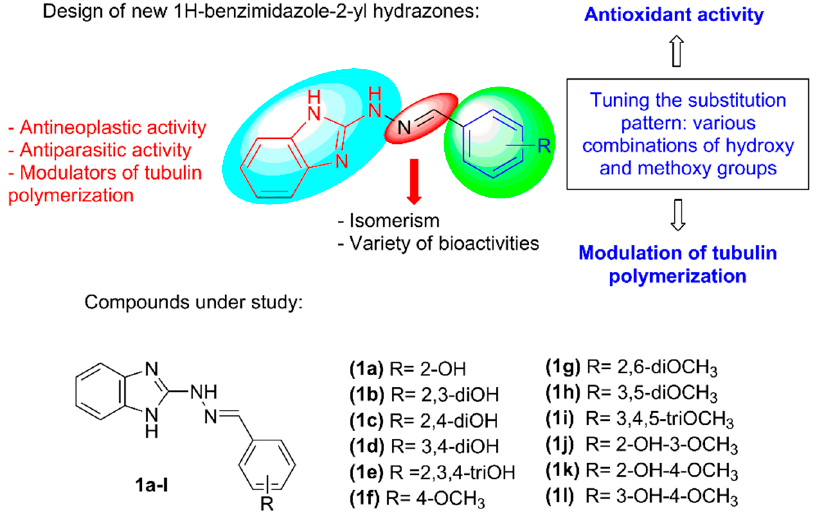
Figure 2. Molecular structure design of 1H-benzimidazole-2-yl hydrazones and compounds under study.